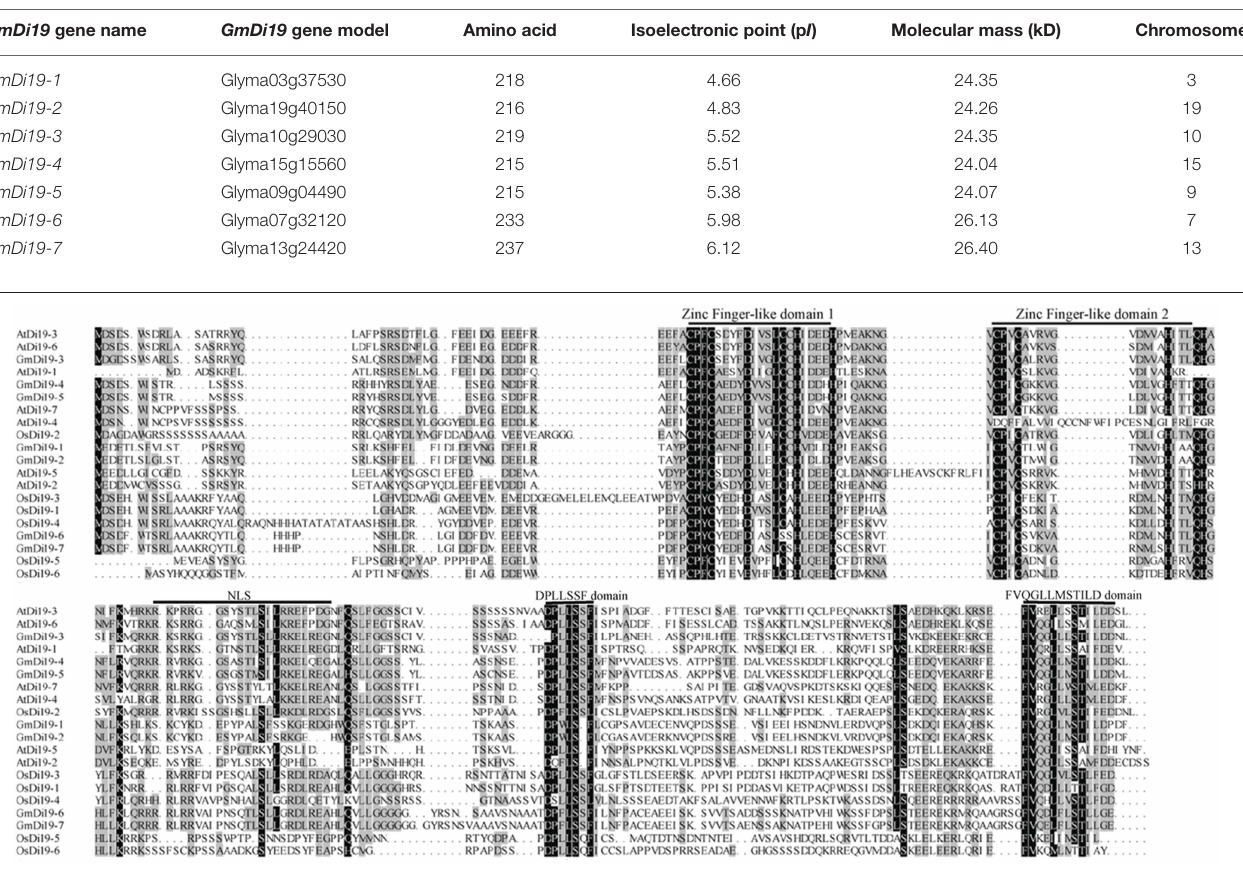
TABLE 1 | Nomenclature for Di19s in soybean.